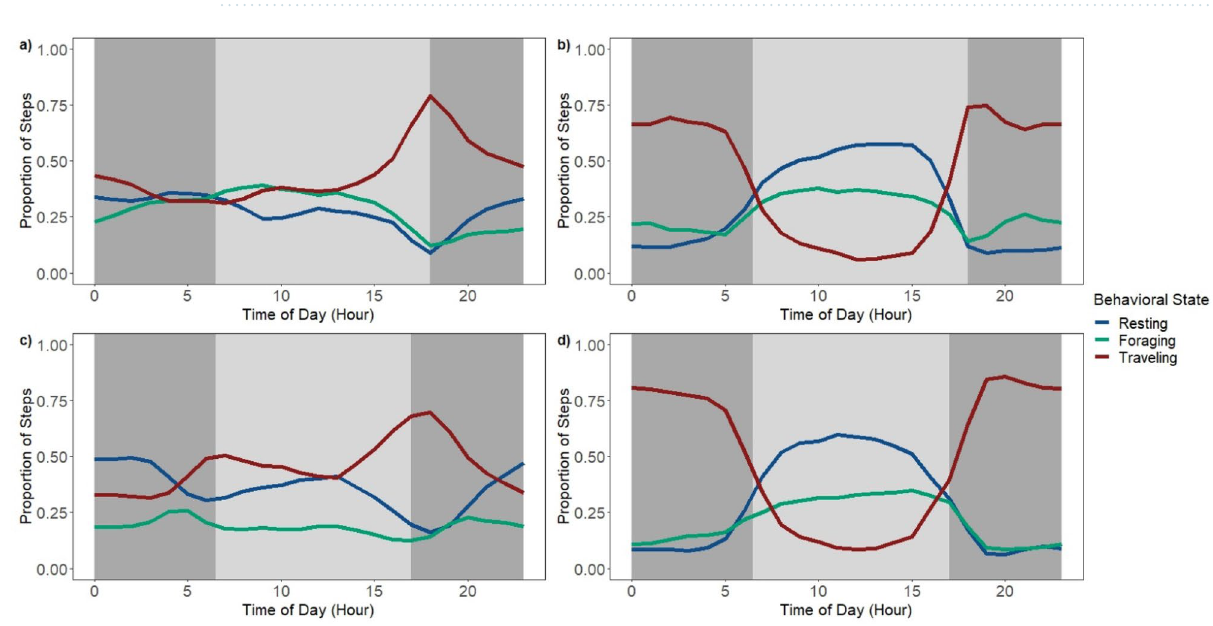
Figure 4. Proportion of steps per hour for each behavioral state of wild pigs ( Sus scrofa ) on the Savannah River Site in South Carolina by sex and season: ( a ) females in low-forage months (January–April); ( b ) males in low- forage months; ( c ) females in high-forage months (May–December); ( d ) males in high-forage months. The dark gray bars represent average nighttime hours while the light gray bar represents the average daytime